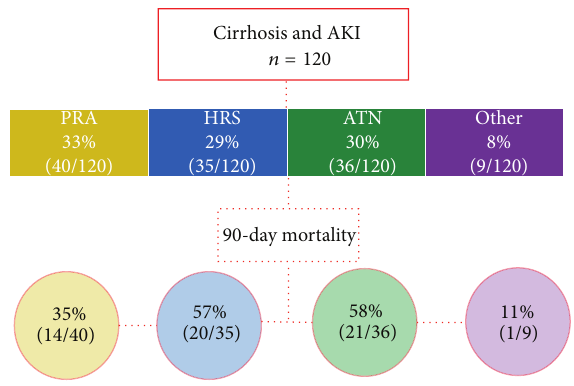
Figure 1: Distribution of participants and 90-day mortality. AKI (acute kidney injury), PRA (prerenal azotemia), HRS (hepatorenal syndrome), and ATN (acute tubular